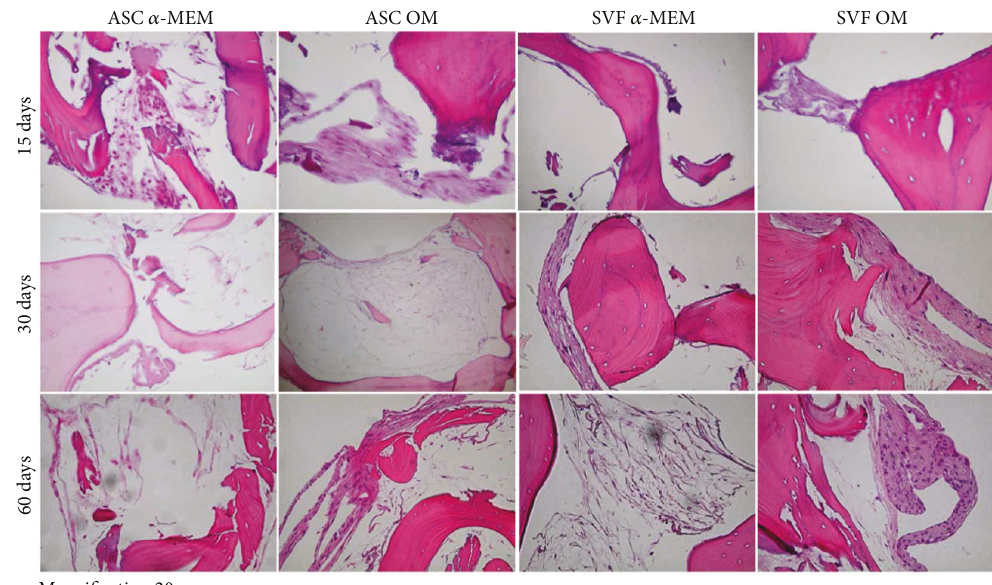
Figure 3: H&E staining to monitor SB colonization by ASCs and SVF. Both ASCs (left panels) and SVF (right panels) grow on SB in the absence of α -MEM or in osteogenic medium (OM). The presence of new tissue formation is evident since 15 days of culture, and it increases over time. Images of H&E staining are reported for each time point (15, 30, and 60 days). Magni fi cation